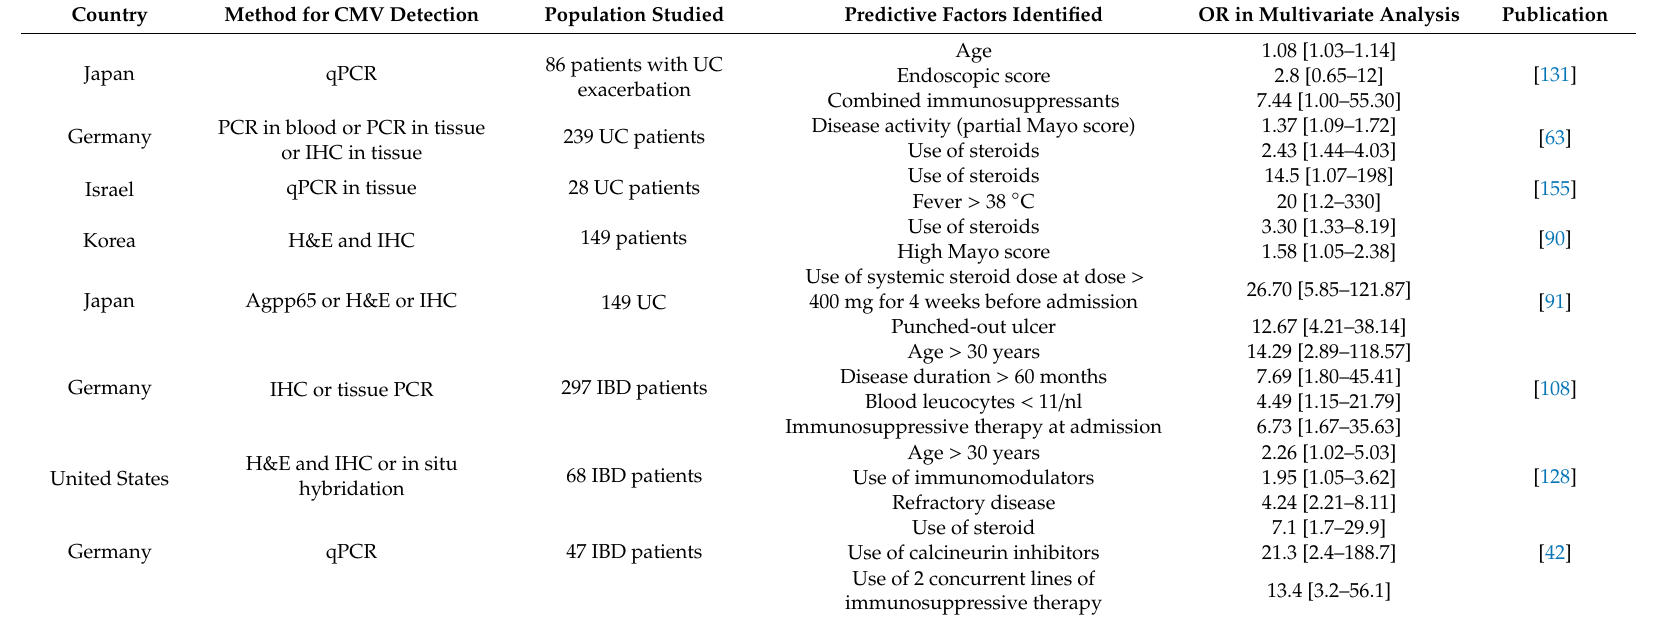
Table 4. Predictive factors for CMV colitis in UC